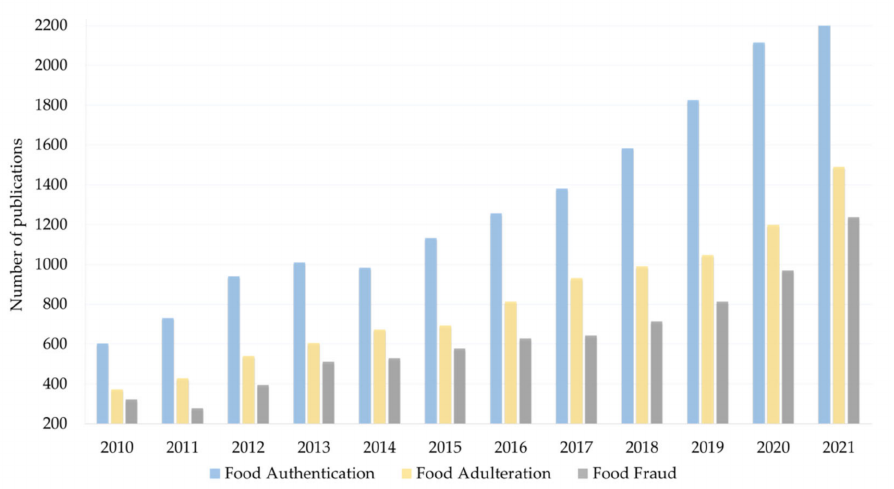
Figure 1. Number of publications in the last decade from Science Direct using search keywords “food authentication”, “food adulteration”, and “food fraud”. Accessed on 16 November